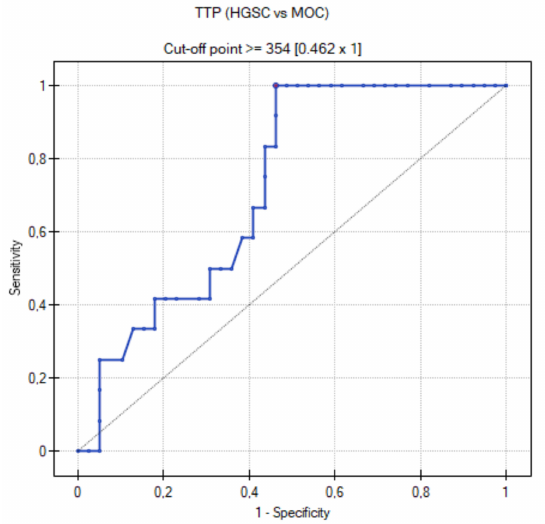
Figure 15. ROC curve for diagnostic performance of TTP parameter in detection of EOC (HGSC vs. MOC).